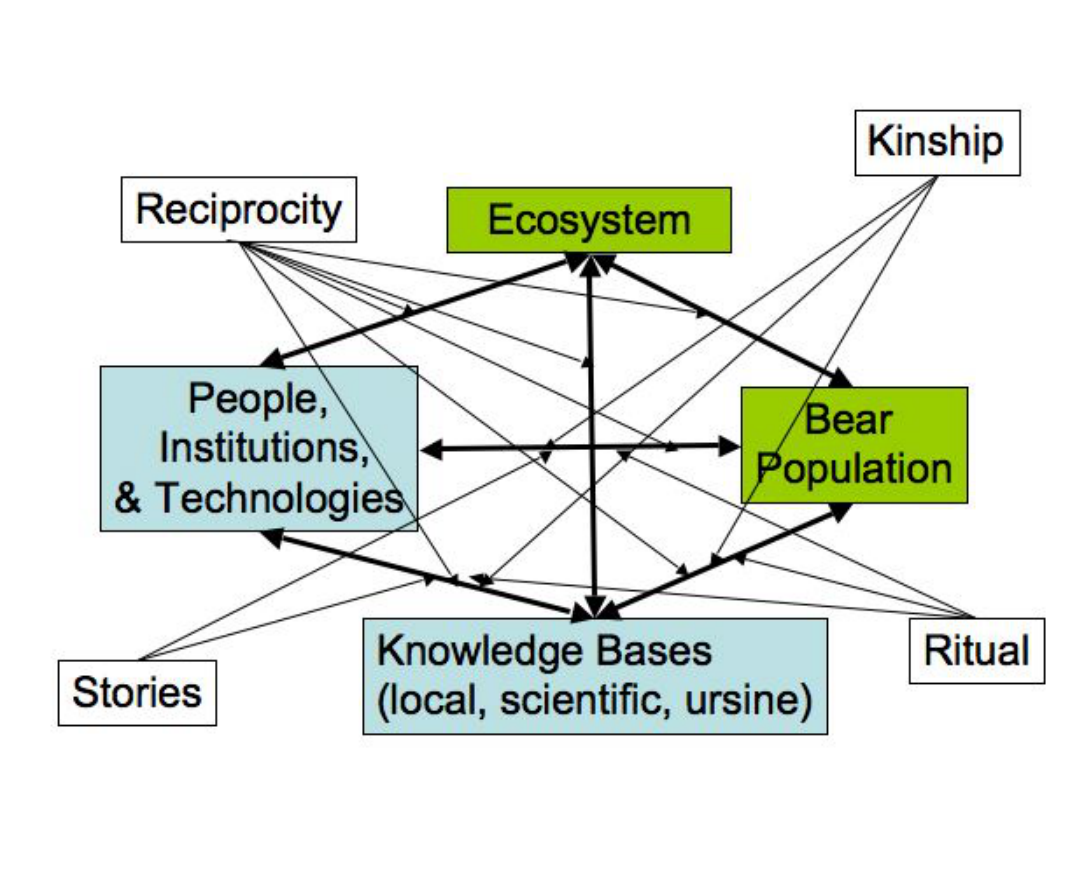
Fig. 3. Linkages in bear-human systems are influenced by the four different types of practices of